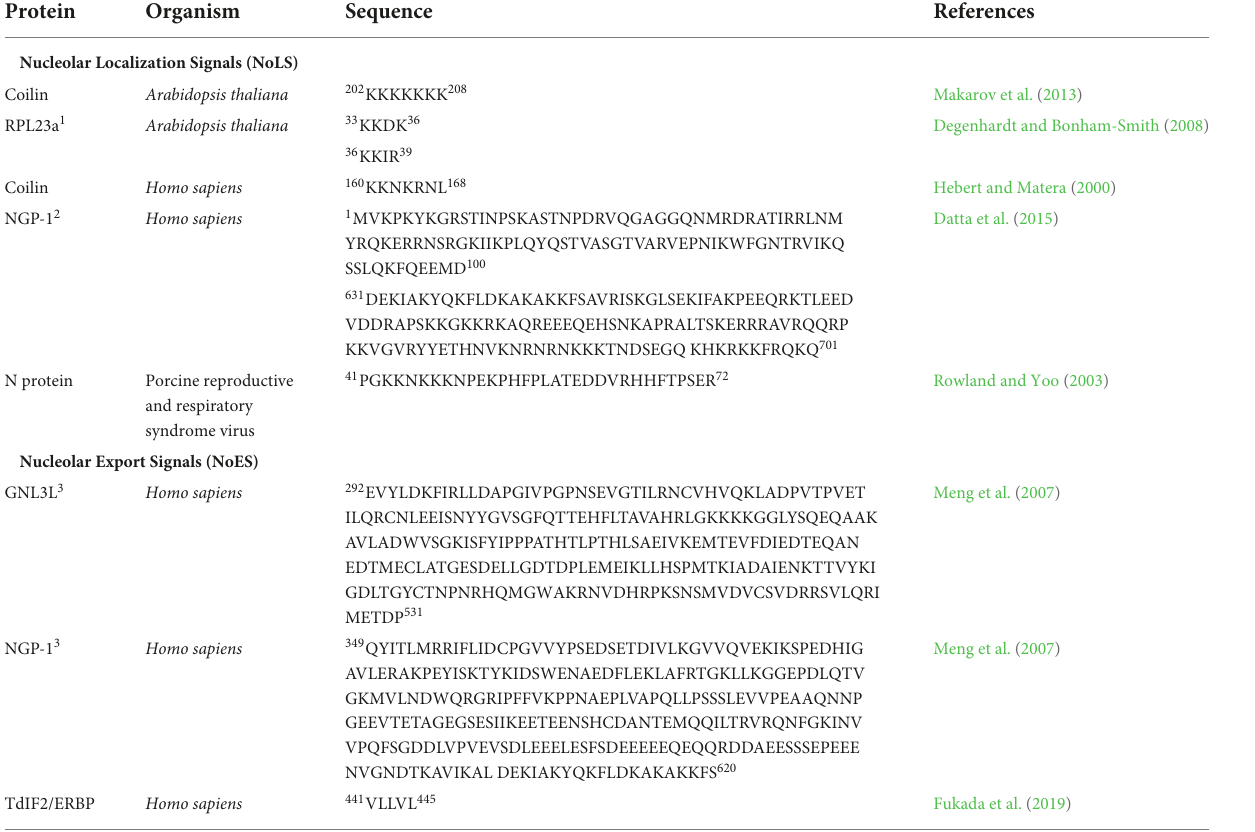
TABLE 4 Nucleolar localization signals and nucleolar exclusion